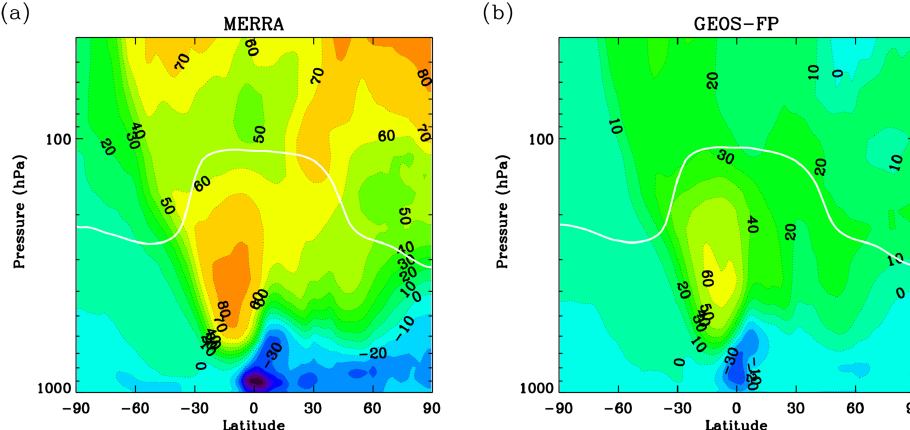
Figure 14. Percentage changes in zonal mean 222 Rn concentrations averaged over June–July–August due to convective transport in the GEOS-Chem simulations driven by (a) MERRA and (b) GEOS-FP. Values are ( 222 Rn − 222 Rn nc )/ 222 Rn × 100, where 222 Rn and 222 Rn nc are 222 Rn concentrations simulated with (A1 and B1, Table 2) and without (A1-nc and B1-nc) the convection operator,